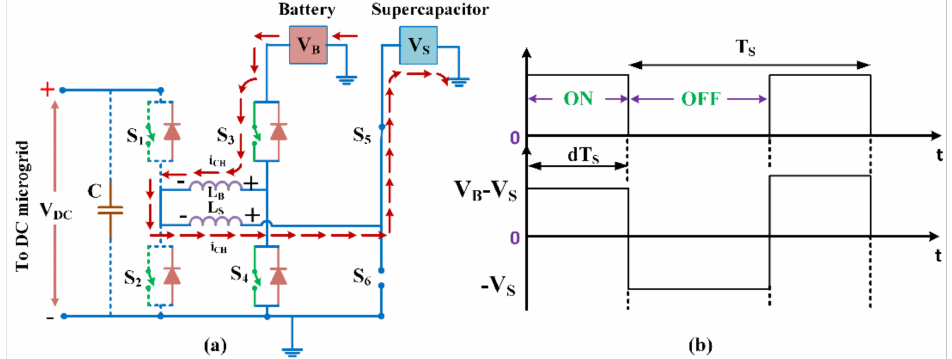
Figure 5. HESS energy exchange method of operation: ( a ) equivalent circuit and ( b ) steady-state